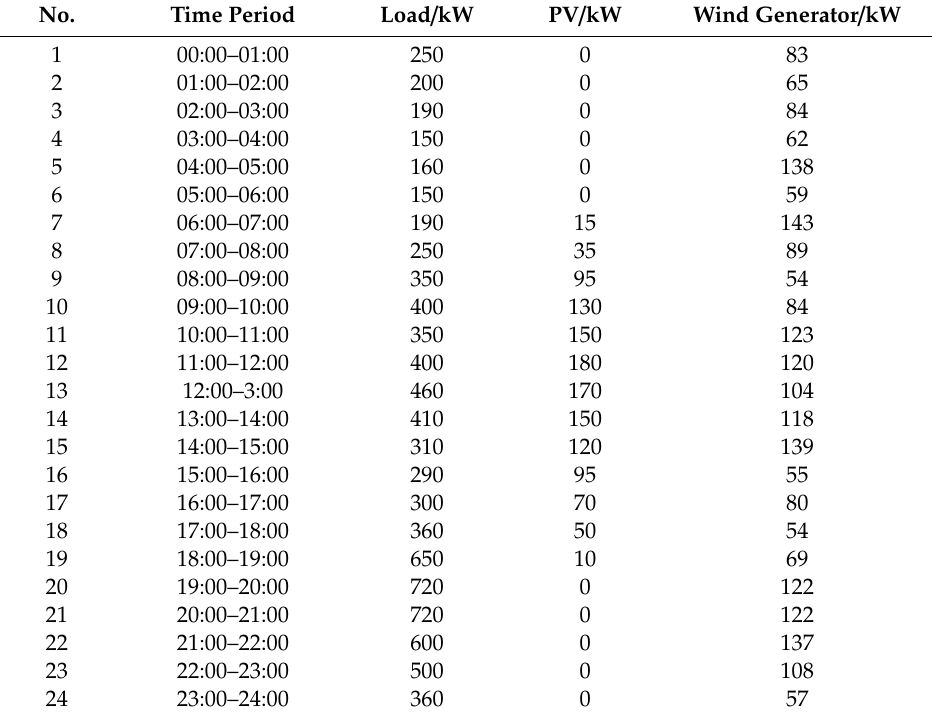
Table 1. Daily load, wind generator output and photovoltaic (PV) output.